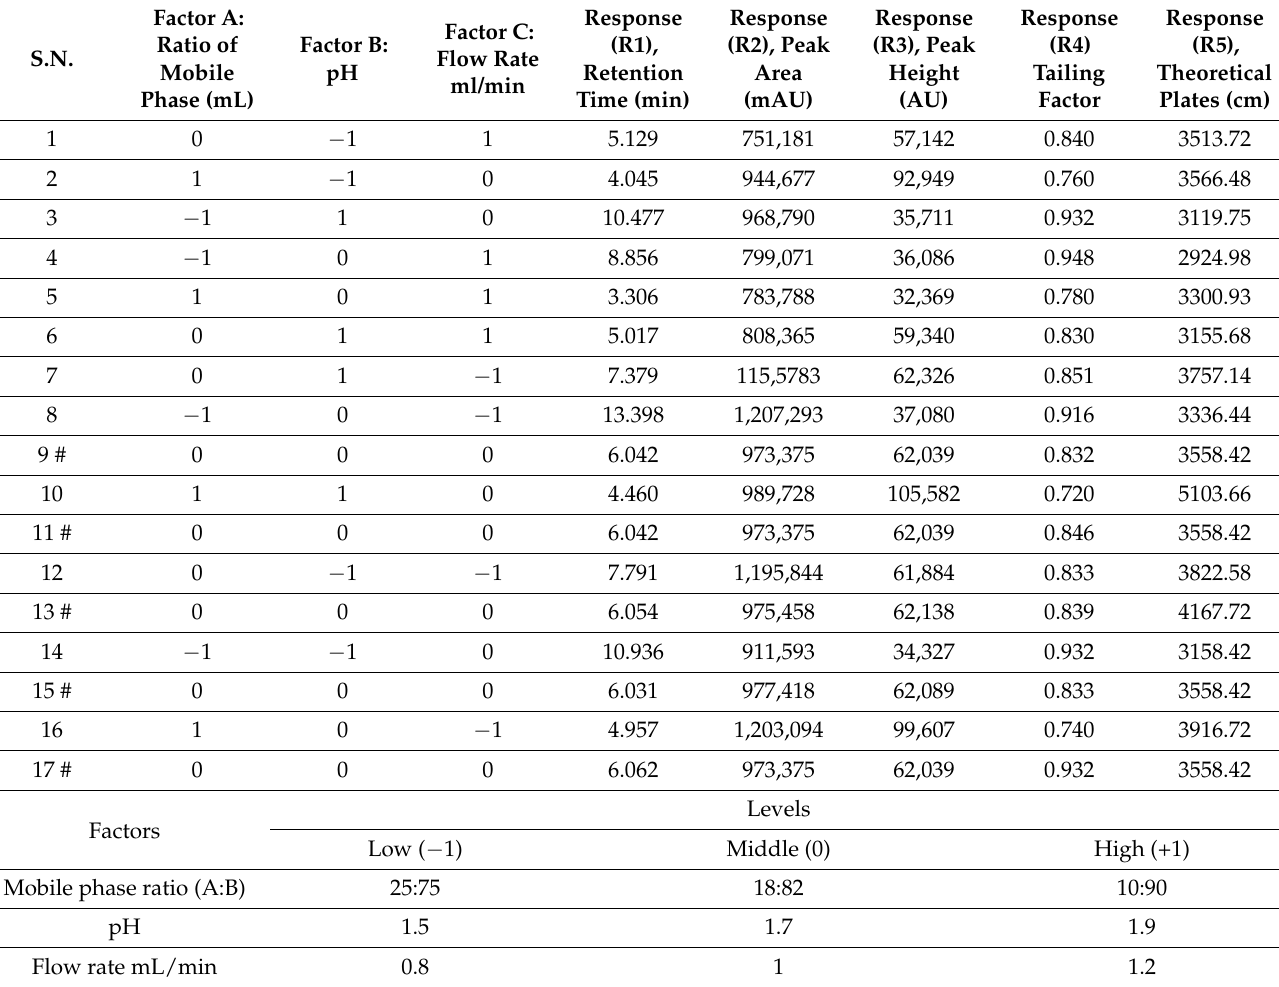
Table 2. Box–Behnken design representing the effects of independent variables on dependent variable at low, medium and high